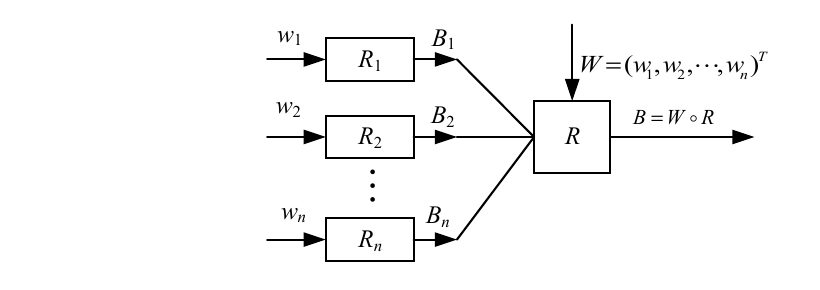
Figure 5. The two-layer fuzzy composite judgment diagram.